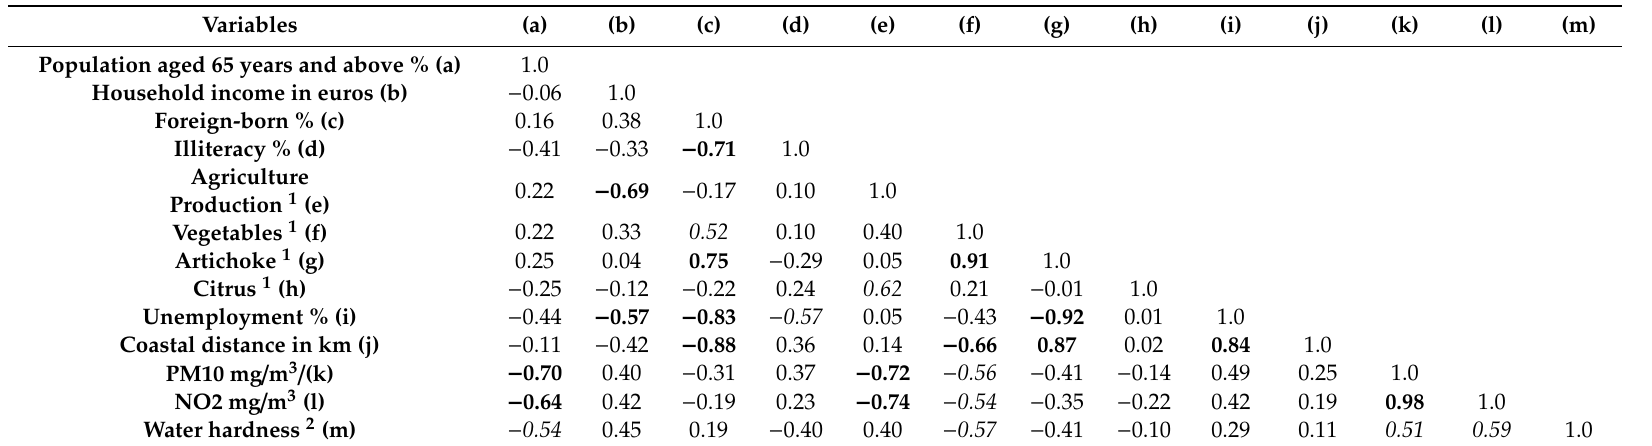
Table 2. Spearman correlation coe ffi cients among independent variables (Castell ó n, 1991–2011 period).